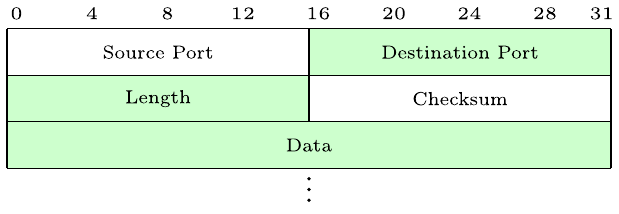
FIG. 7. UDP header. All fields causing dependencies for the packet header of the reply are marked in